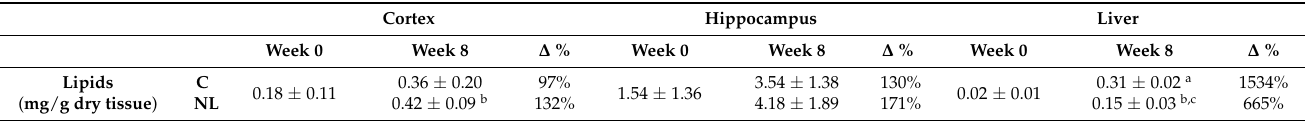
Table 4. Total lipid mass (mg/g dry tissue) in the cortex, hippocampus, and liver of mice before (week 0) and after 8-week nanoliposome treatment. The values are expressed as the mean ± SD. Statistical differences ( p < 0.05) are shown for each tissue; week 0 is compared with week 8 for the control (C) group a and week 8 for the nanoliposome (NL) group b , and for week 8 the C group is compared with the NL group c . ∆ % represents the percentage of